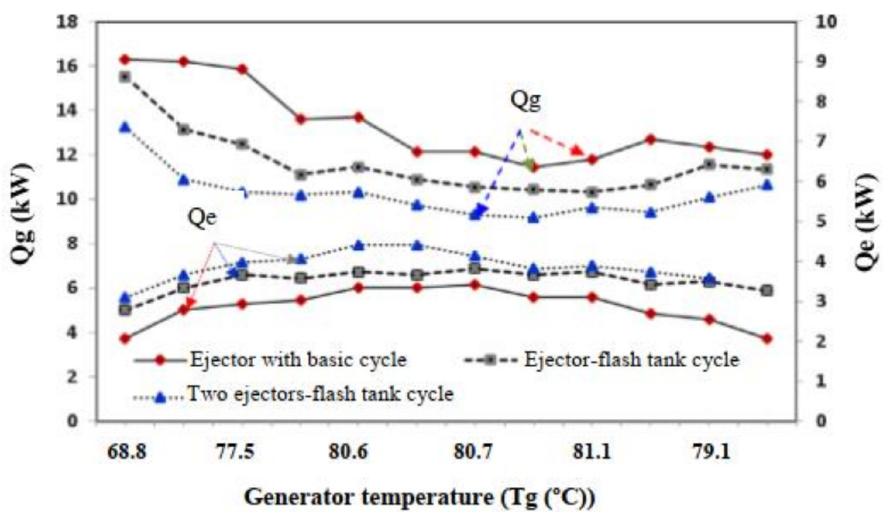
Figure 11. Change of evaporator and generator thermal loads with generator temperature for different cycle configurations [51].